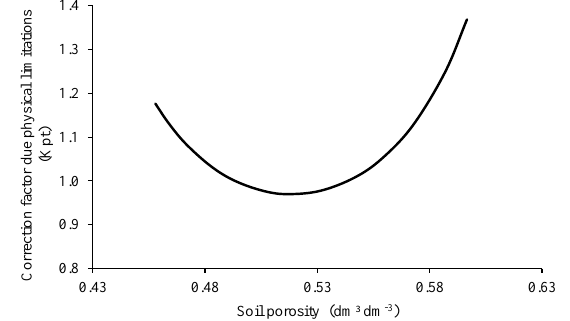
Figure 8. Soil porosity dependence of the modifier of microbial death rate due to limitations of physical conditions (Kpt) used in ForPRAN model simulations (source: the equation used in the Kpt modifier was parameterized with data presented in Silva et al., 2011).